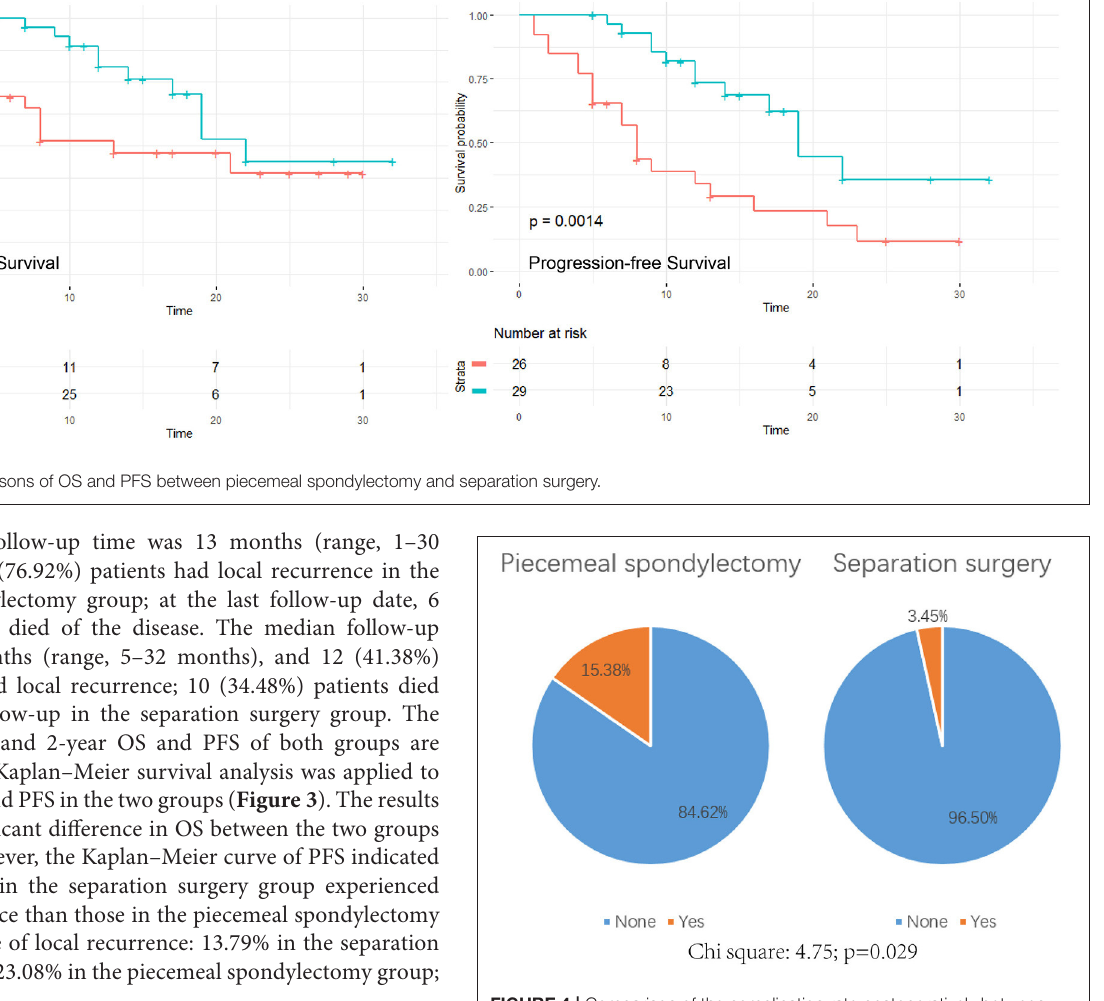
FIGURE 4 | Comparison of the complication rate postoperatively between piecemeal spondylectomy and separation surgery. Chi-square: 4.75; p =